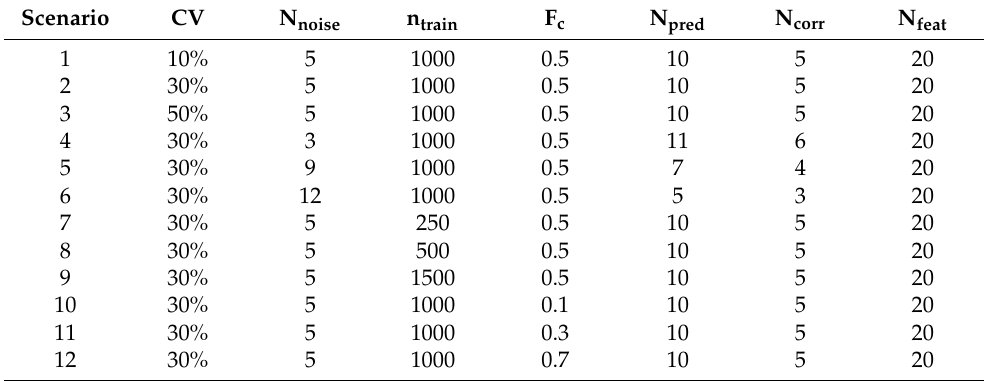
Table 2. Summary of simulated scenarios.